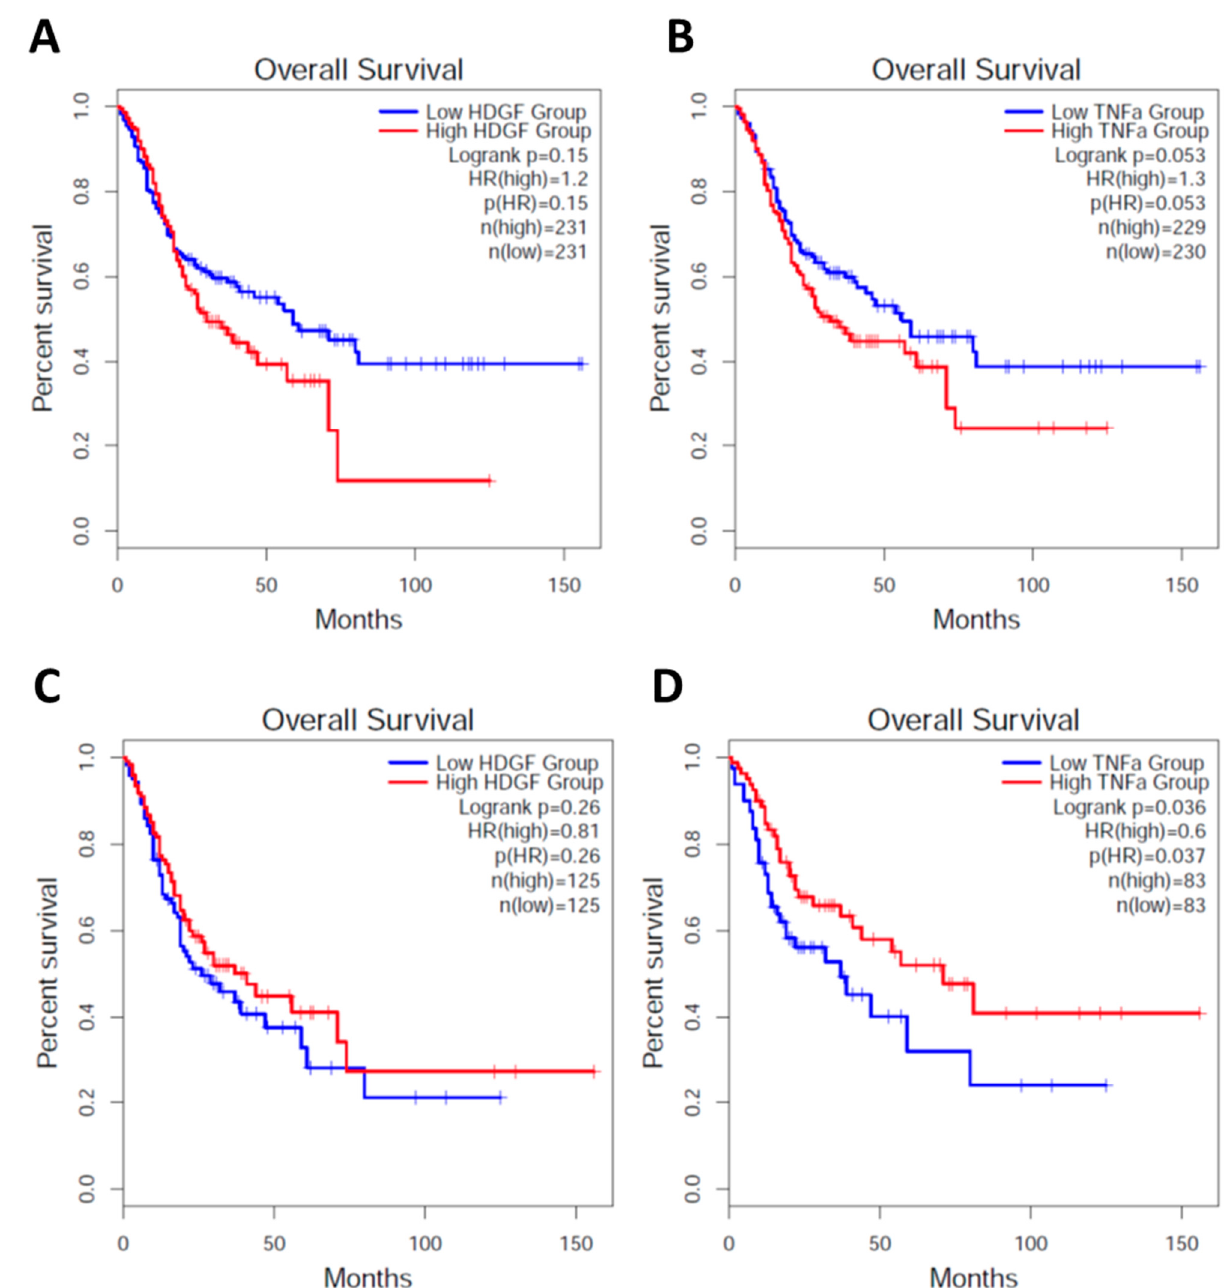
Figure 5. Survival curve of patients with high or lower expressed HDGF or TNF α . A total of 231 patients were surveyed using GEPIA2 (h tt p://gepia2.cancer-pku.cn/#survival, accessed on 10 May 2019) as described in the Methods section; ( A , B ) are non-normalized by the CagA gene; ( C , D ) are normalized by the CagA gene.